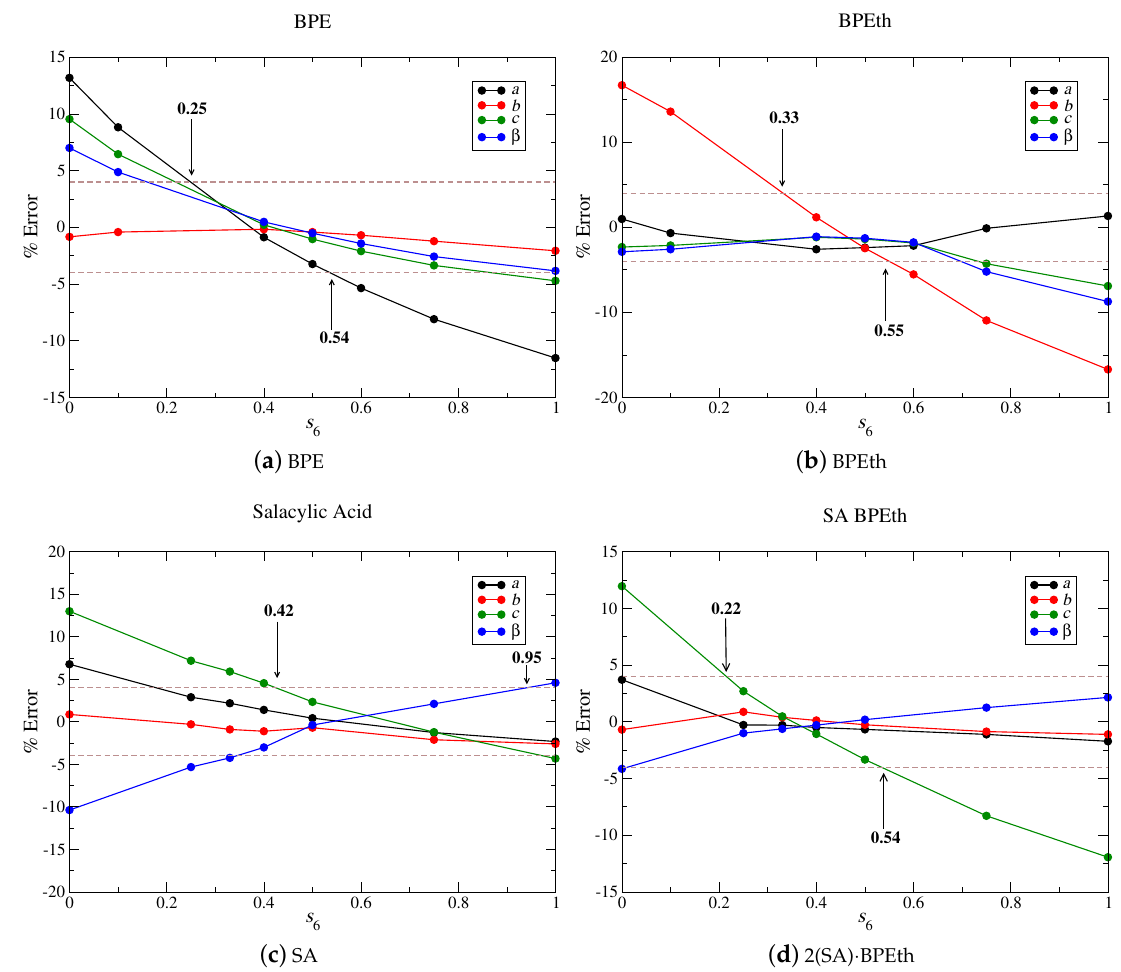
Figure 14. For co-crystal components ( a ) BPE; ( b ) BPEth; and ( c ) SA, we vary s 6 from 0 to 1 to determine how DFT-D computed lattice parameters a , b , c , and β will be affected when compared to experimentally determined lattice parameters. The same tests for co-crystal 2(SA) · BPEth yield a similar range of s 6 in which lattice constant underestimation may be minimized. Brown dashed lines denote ± 4% error with respect to experimentally determined lattice